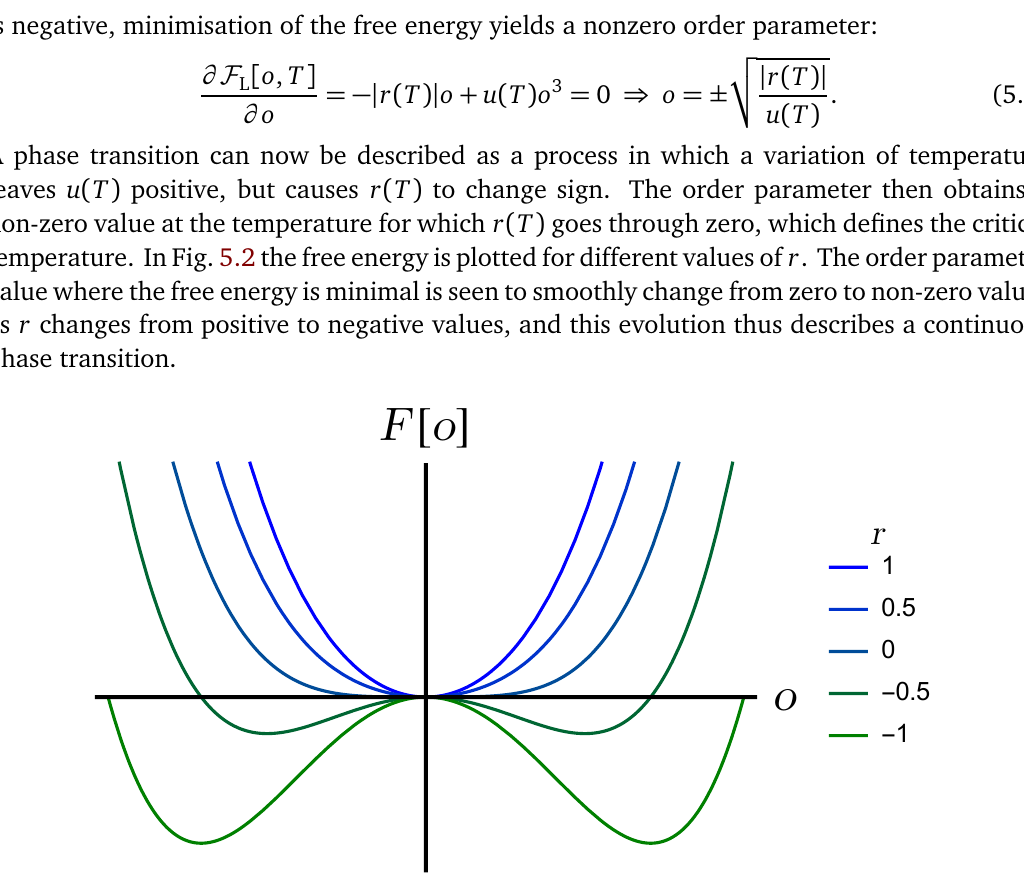
Figure 5.2: The Landau free energy as a functional of the order parameter o during a continuous phase transition described by Eq. (5.2), with u > 0 for several values of r . The minimum of F moves continuously from zero tot non-zero values as r L decreases from positive to negative